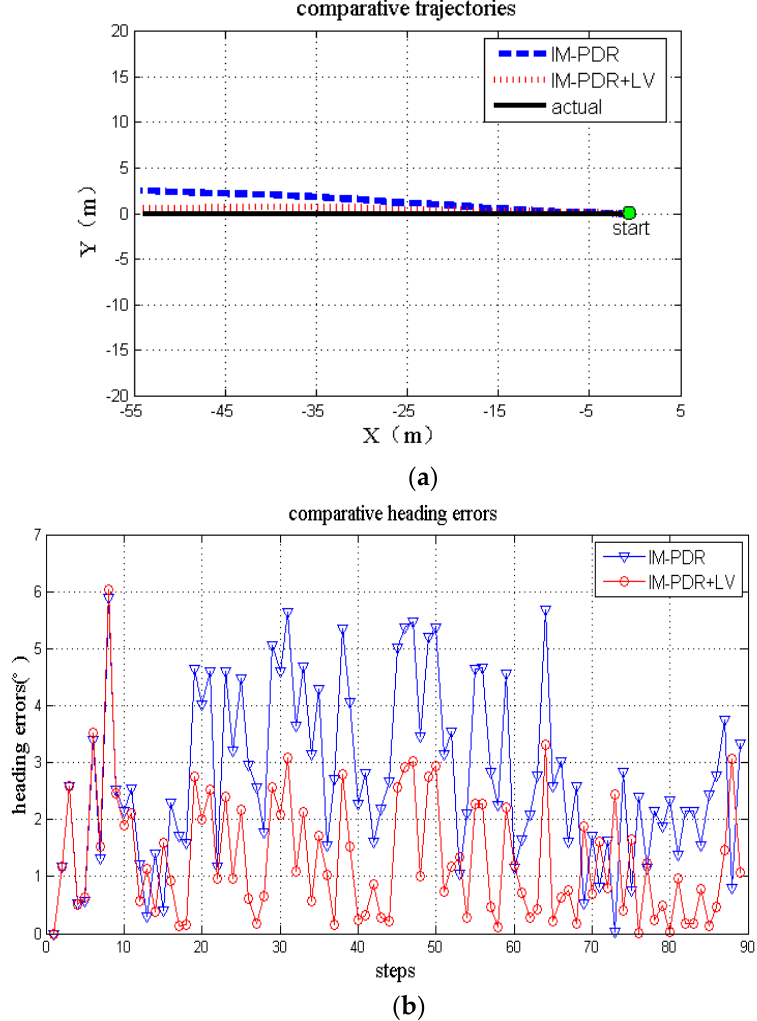
Figure 9. Results of straight line test: ( a ) comparative trajectories; ( b ) comparative heading errors.